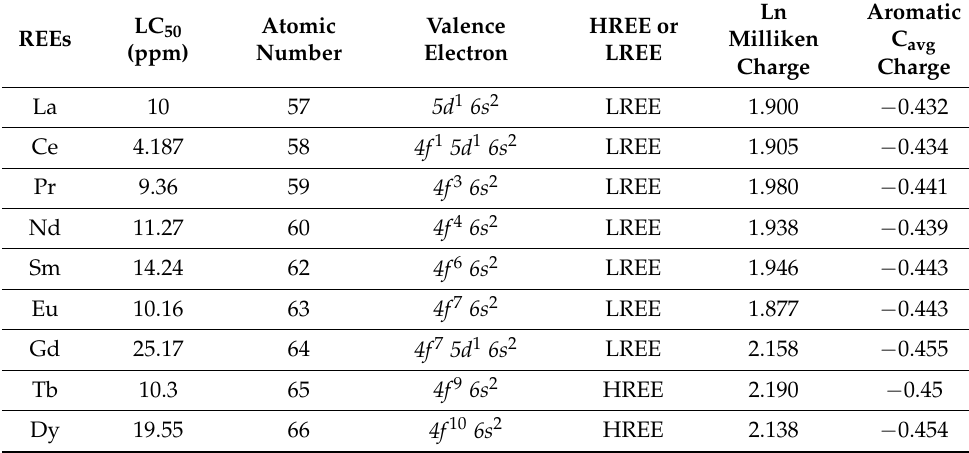
Table 1. Lists are LC 50 , Lanthanide’s atomic number, an index for heavy rare earth elements, Lan- thanide’s charge, and aromatic C avg